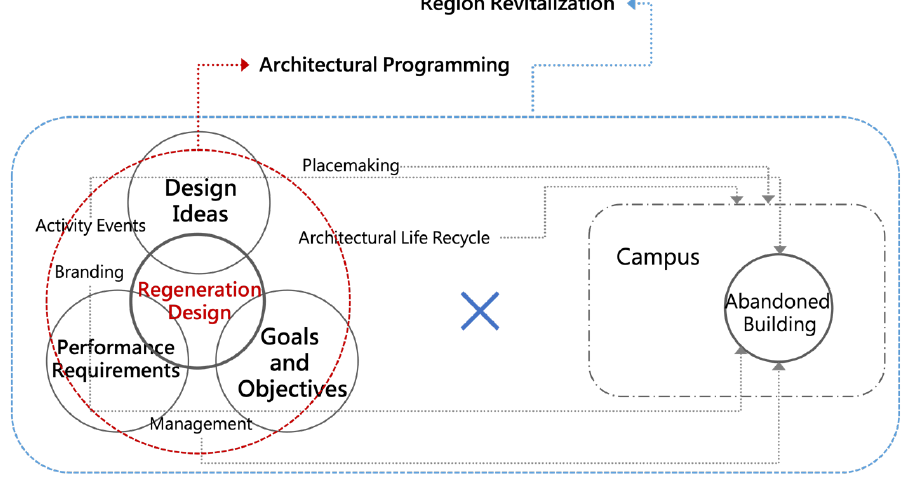
Figure 3. Concept of Abandoned Architecture Environment Redesign Process.